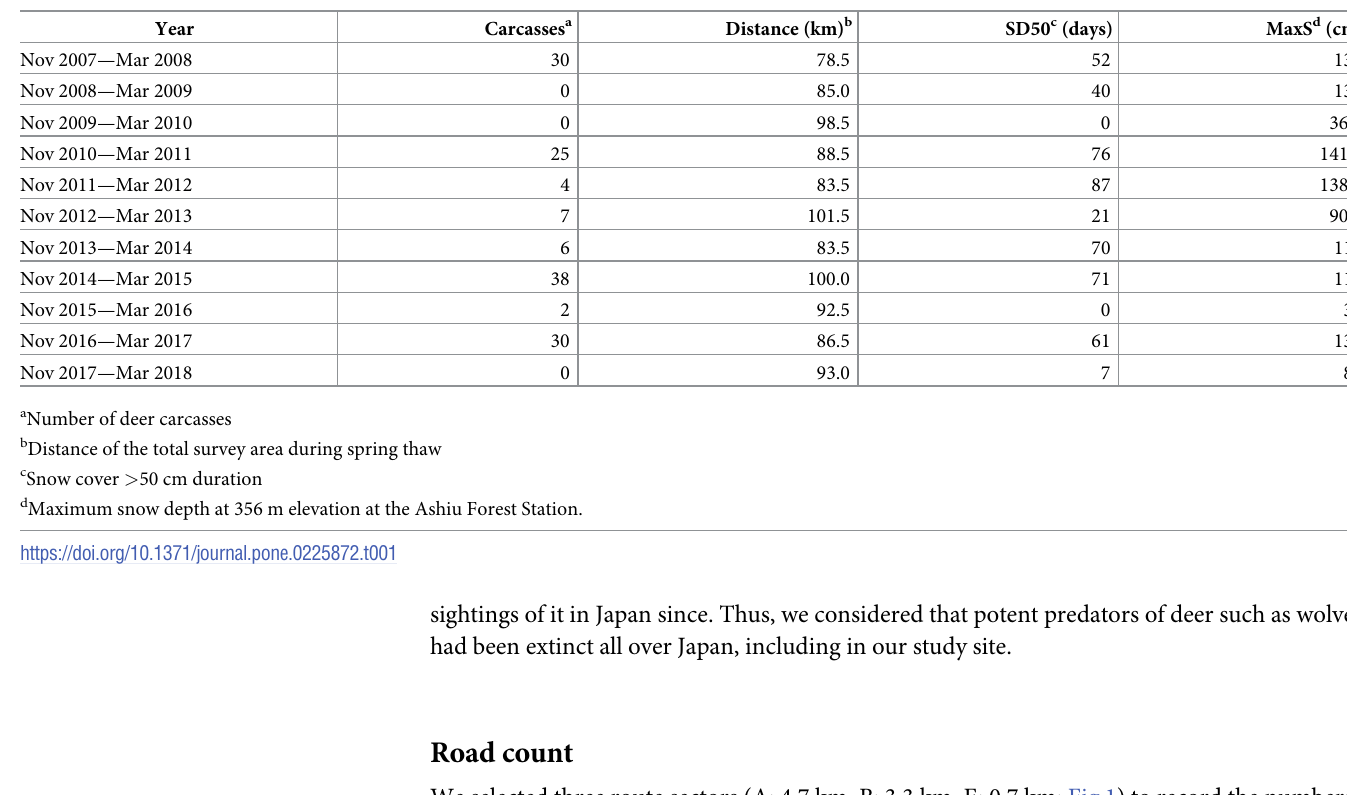
Table 1. The numbers of deer carcasses in winter and winter climate.